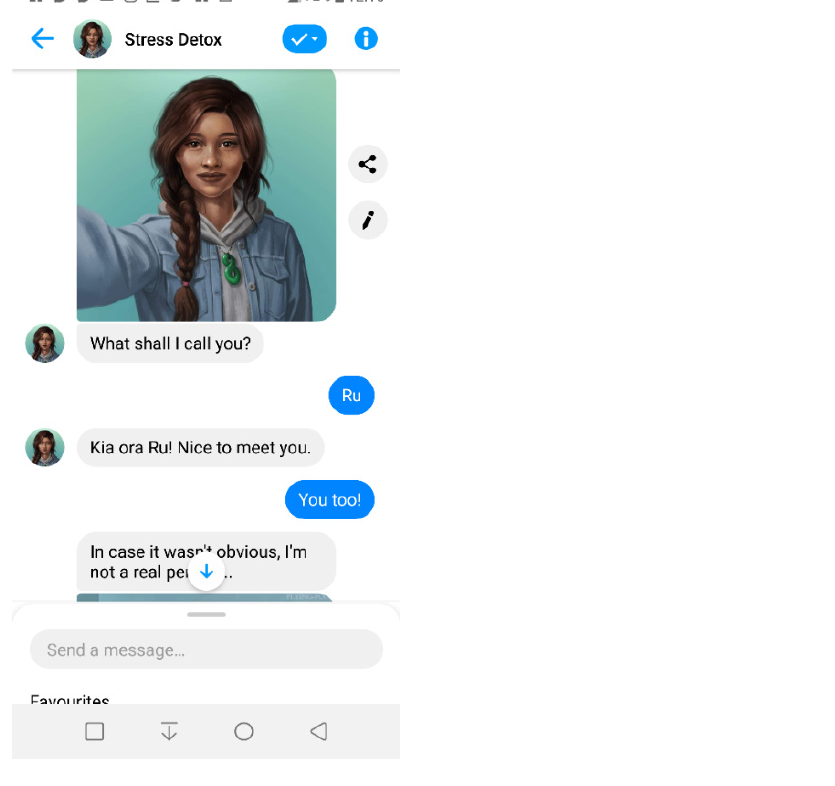
Whenever possible, text is reduced and kept simple and non-technical. Jargon is avoided and, instead, more colloquial, youth friendly language is